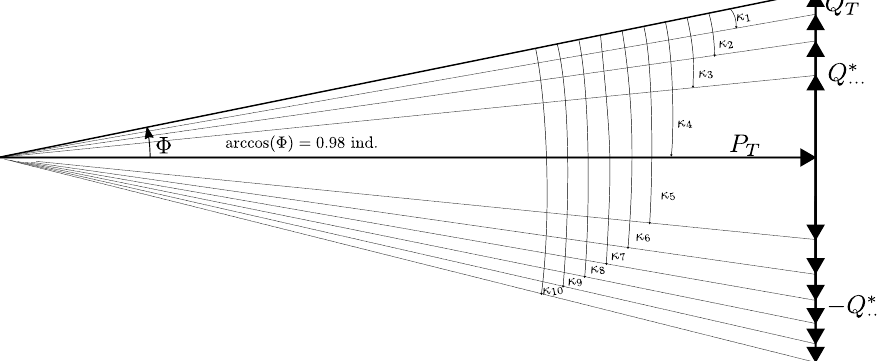
Figure 17. Illustration of the adjustment of power factor for mobile reactive power compensation.